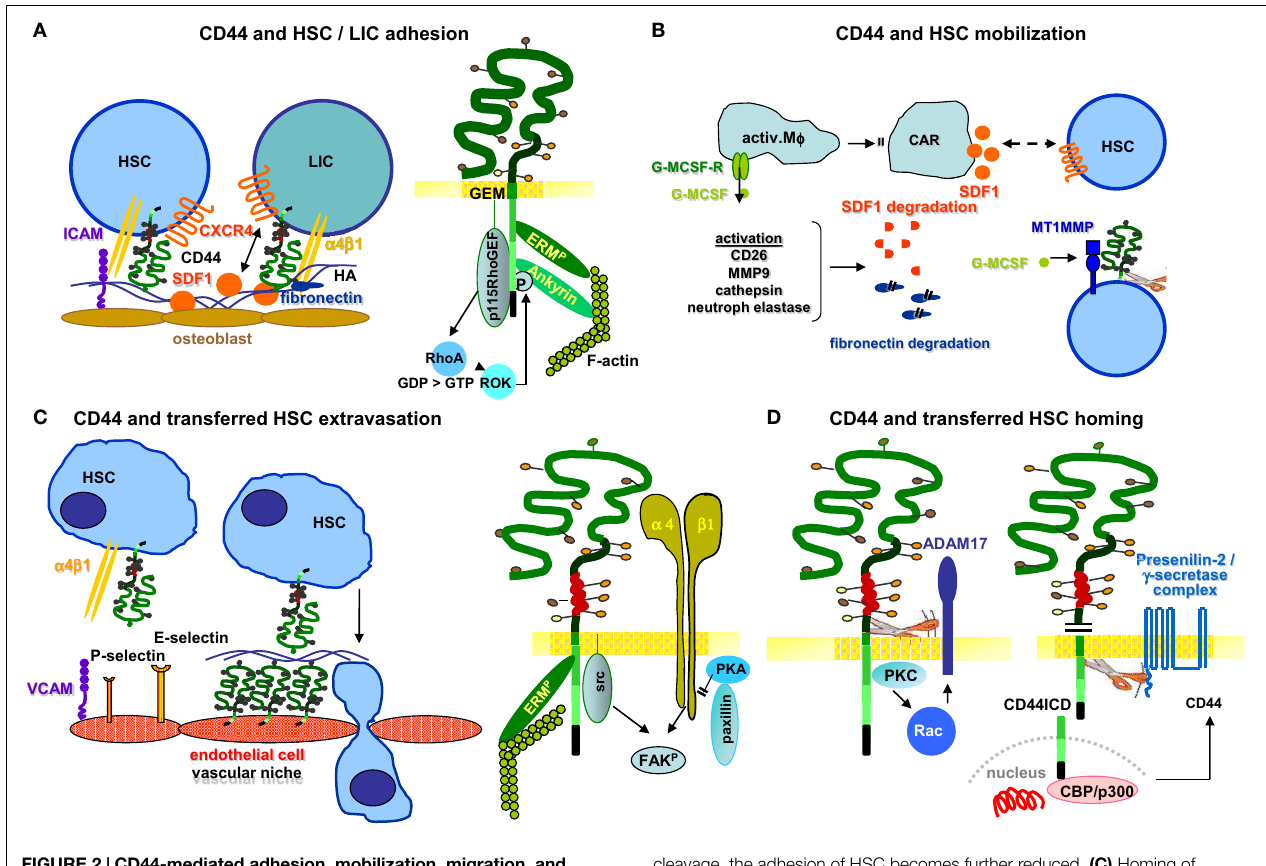
FIGURE 2 | CD44-mediated adhesion, mobilization, migration, and homing in HSC/LIC . (A) HSC and LIC adhesion to the HA-rich endosteal niche is supported by α 4 β 1, which binds to fibronectin and via ICAM to osteoblasts. CD44-associated CXCR4 binding to stroma-derived SDF1 is of major importance in retaining HSC in the osteogenic niche. One of the adhesion strengthening signaling pathways proceeds via the CD44-crosslinking initiated activation of ERM and ankyrin, which includes activation of a RhoGEF that interacts with RhoA and stimulates ROK. This strengthens ankyrin phosphorylation and the F-actin linkage. (B) To interfere with the retention of HSC in the osteogenic niche for PBL-HSC transplantation, adhesion requires to be loosened. This is achieved by blocking CD44 and/or α 4 β 1, and most commonly by G-MCSF that binds to BM-M ϕ , which leads to activation of several proteases that degrade SDF1 and fibronectin. In addition, CAR become attacked and secrete less SDF1. Finally, G-MCSF leads to CD44-associated MT1MMP activation in HSC. By the CD44